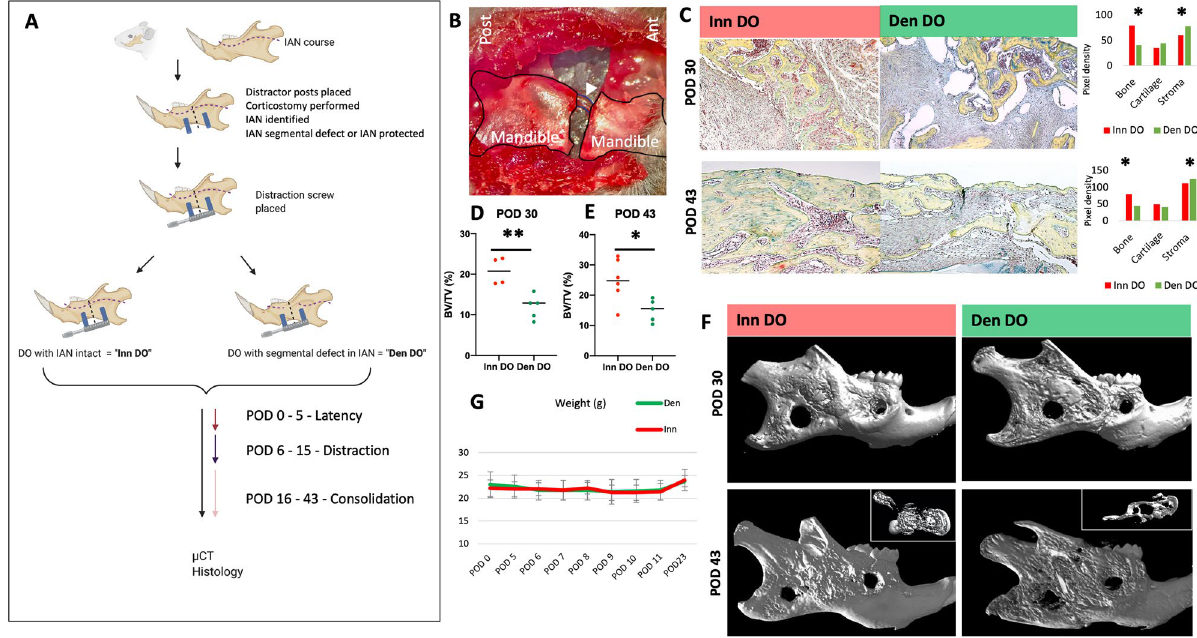
Figure 1. Denervation of IAN during DO leads to impaired histological and radiological osteogenesis. ( A ) Experimental schematic: C57Bl6 mice underwent distractor placement with or without a segmental resection (“segmental defect”) of the IAN. The mice then underwent 5 days of latency (no distraction), following by 10 days of distraction (POD 5–15), followed by consolidation until POD 43. For histological analysis of osteogenesis, mice were euthanized at specific timepoints and their mandibles underwent histological staining with Movat’s pentachrome. For radiological analysis of osteogenesis, mandibles underwent ex vivo CT scanning, followed by 3 dimensional μCT reconstruction and analysis of the bone regenerate callus mineralized volume fraction (bone volume / total tissue volume, or BV/TV). Created with BioRender.com. ( B ) Microsurgical image of mandible post osteotomy with intact IAN shown. Posterior mandible on left, anterior mandible on right. (Black = background plastic material to ensure improved visualization of IAN for photograph). ( C ) Movat’s pentachrome staining of coronal section of bone regenerate Inn DO (left) vs Den DO (middle) mandibles at the following time-points: POD 30 (top panels) and POD 43 (bottom panels). Orientation left—posterior, right—anterior, 10X. Here, yellow denotes bone formation, blue denotes cartilage formation, purple denotes fibrous stroma formation. (right): Graph demonstrating composition of regenerate (bone, cartilage or fibrous stroma) top = POD 30, bottom = POD 43. Here * denotes p < 0.05. ( D ) Graph demonstrating analysis of POD 30 bone regenerate callus mineralized volume fraction (bone volume/total tissue volume, or BV/TV) of Inn DO (red circles) versus Den DO (green circles) as determined by μCT. ( E ) Graph demonstrating analysis of POD 43 bone regenerate callus mineralized volume fraction (bone volume/total tissue volume, or BV/TV) of Inn DO (red circles) versus Den DO (green circles) as determined by μCT. ( F ) Representative 3-dimensional (3D) μCT reconstructions of Inn DO (left) vs Den DO (right) mandibles at the following time-points: POD 30 (top panels) and POD 43 (bottom panels). Inset demonstrates axial view of the mandible. ( G ) Graph demonstrating no significant difference in body weight (grams) of Den DO (green) and Inn DO (red) mice at multiple timepoints